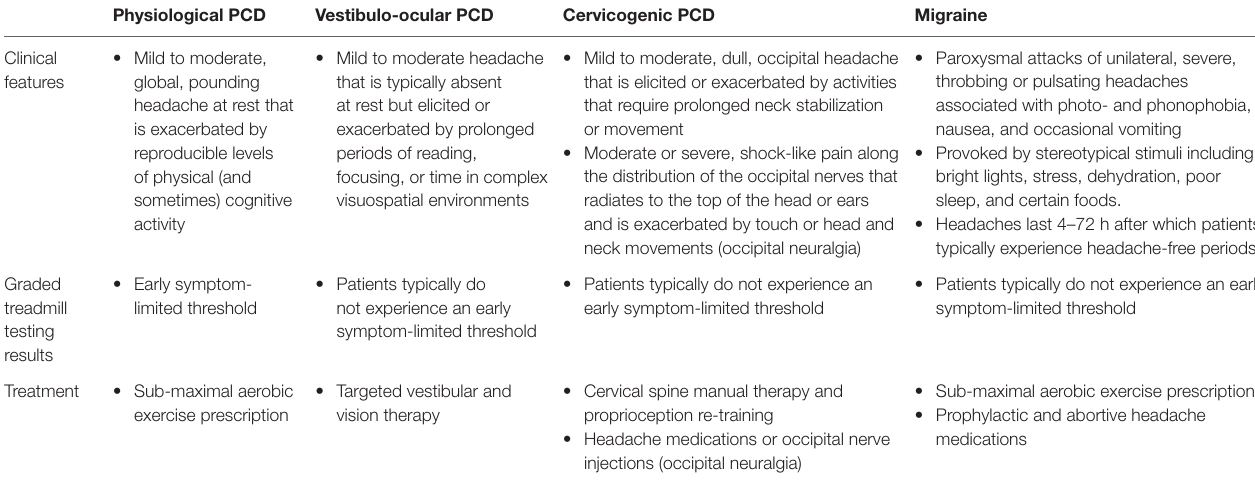
taBLe 2 | summary of the clinical features, graded treadmill testing results, and treatment recommendations for the main types of headache that occur in post-concussion syndrome patients. physiological pCd